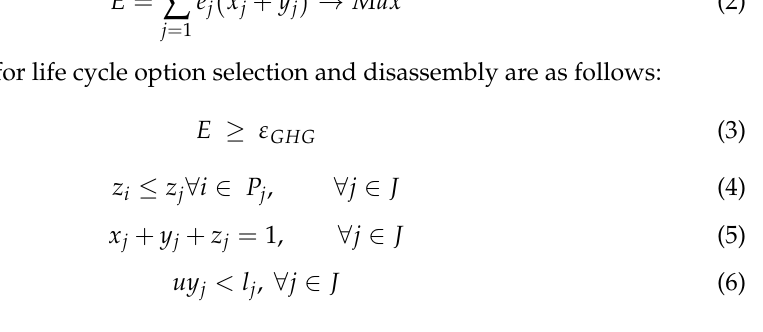
Table 2. Notation of parameters and variables used in this study .